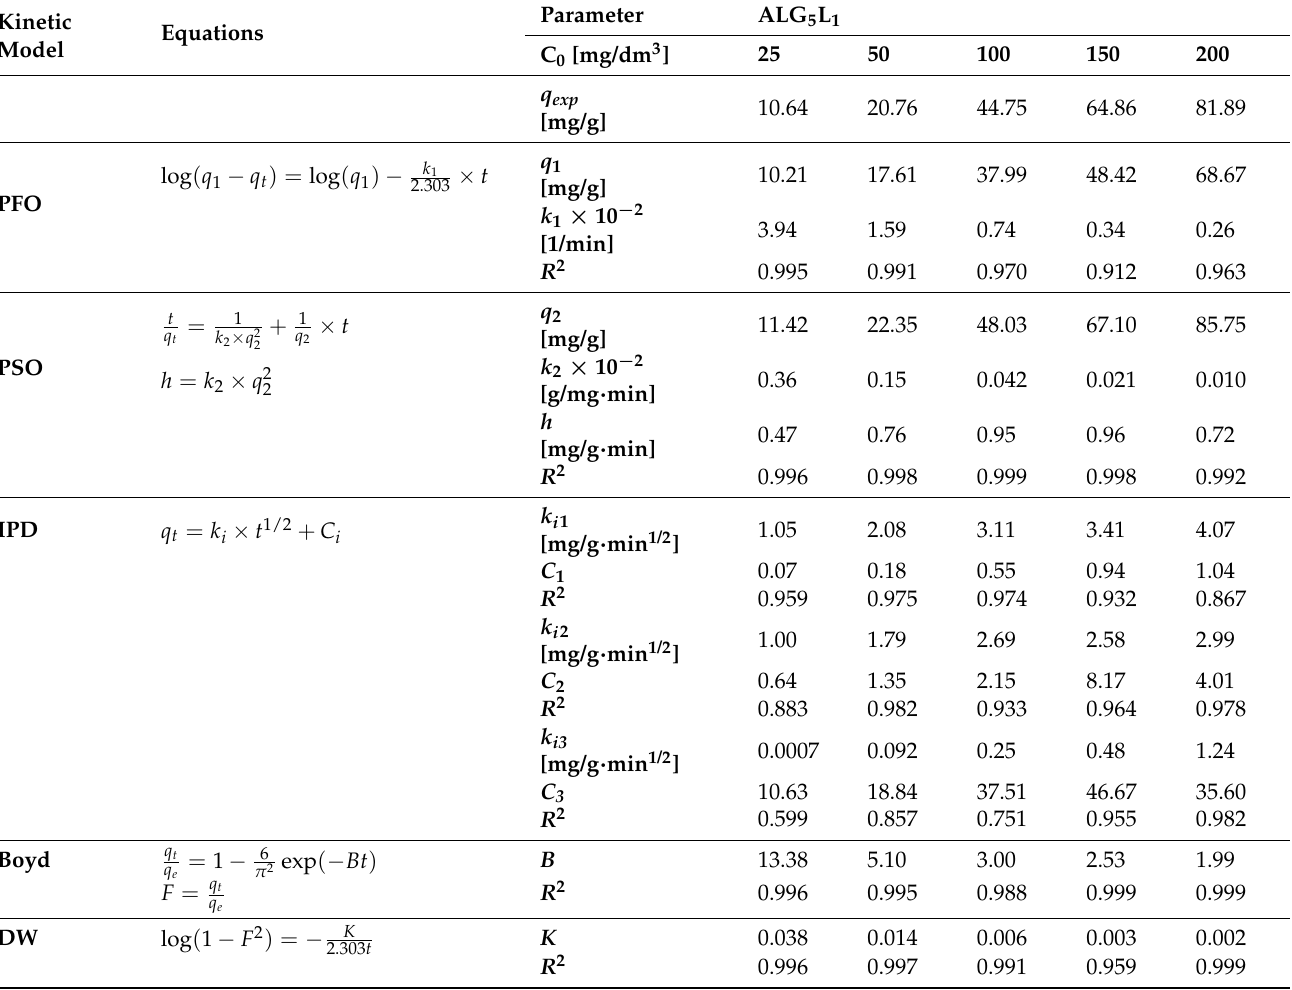
Table 1. Calculated kinetic parameters for the La(III) ions sorption onto the ALG 5 L 1 composite a . Kinetic